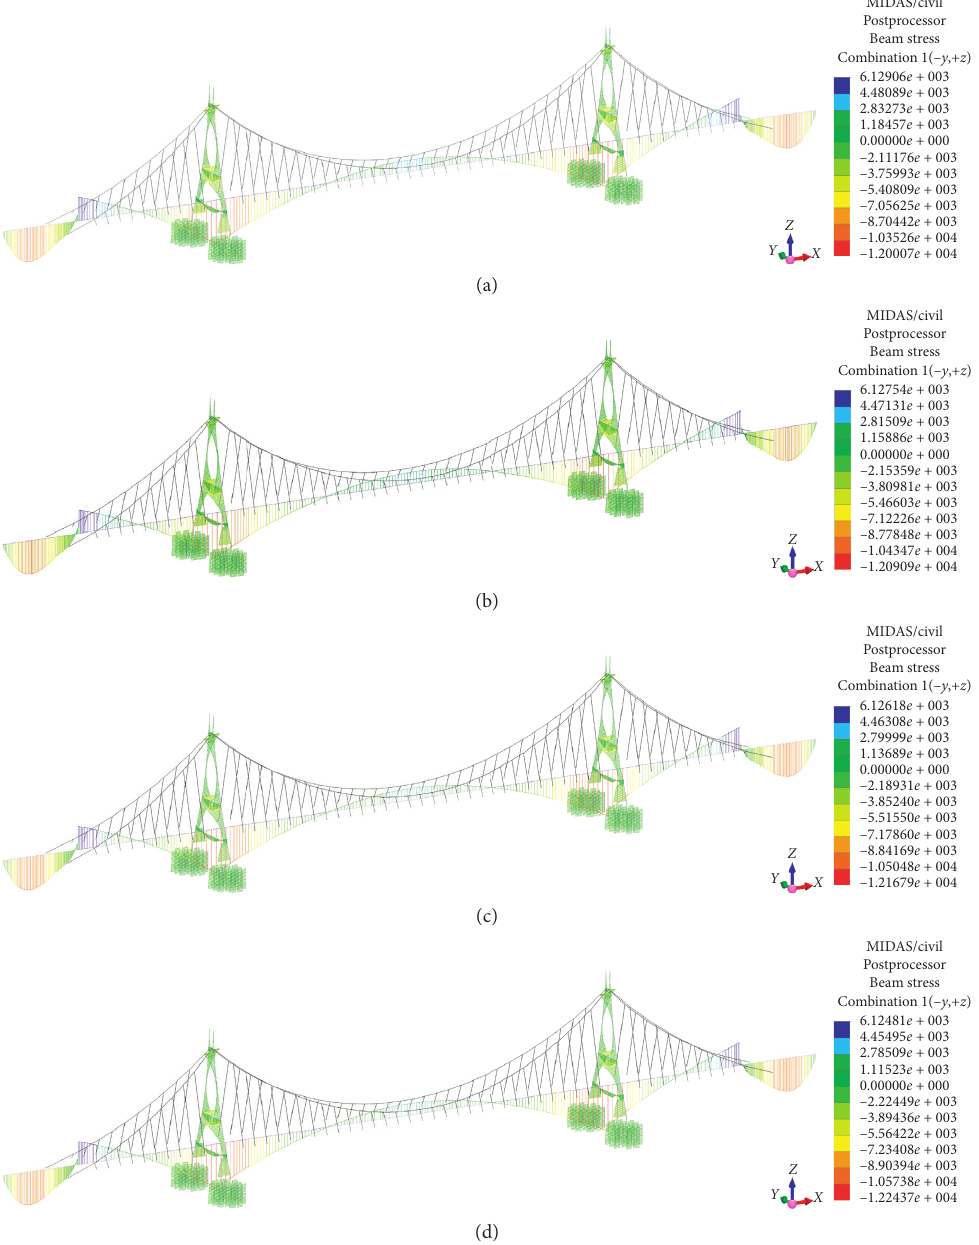
Figure 10: Bending moment change of the main beam. (a) Tensioning stage 1. (b) Tensioning stage 2. (c) Tensioning stage 3. (d) Tensioning stage